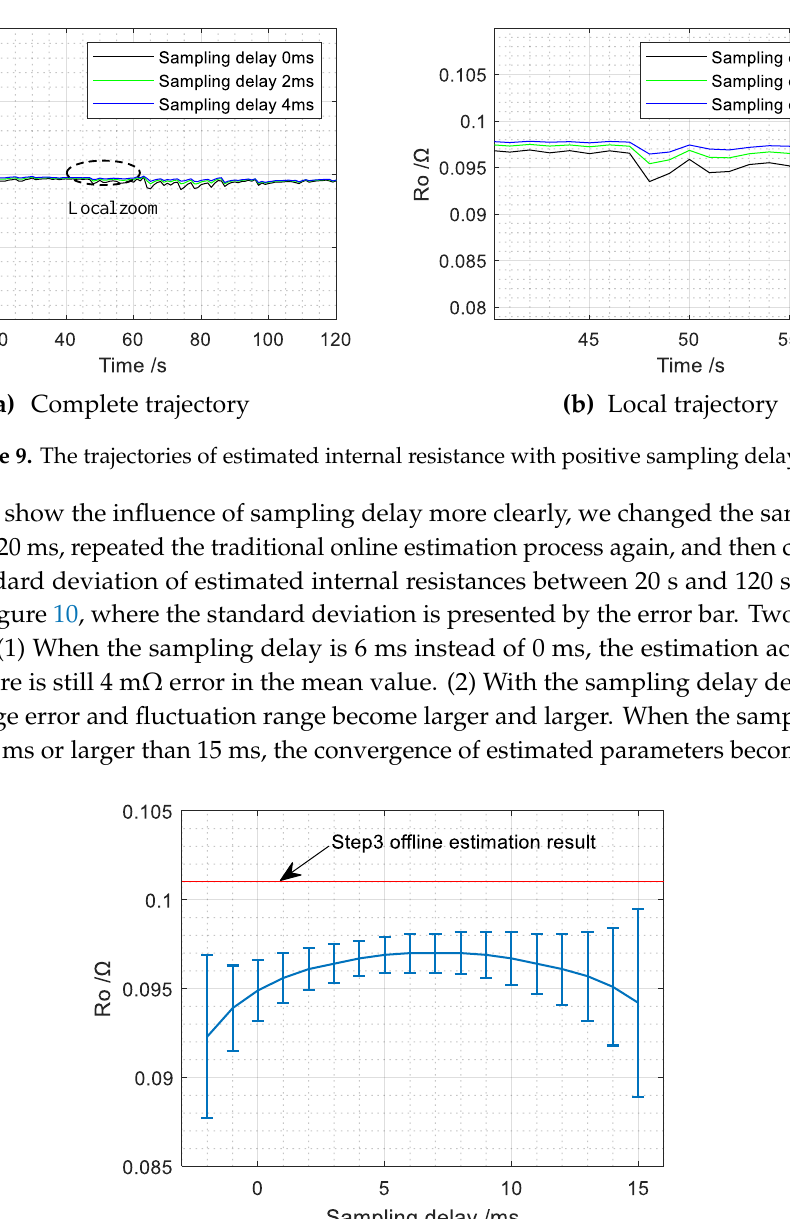
Figure 10. The mean value and standard deviation of estimated internal resistance under different sampling delays.